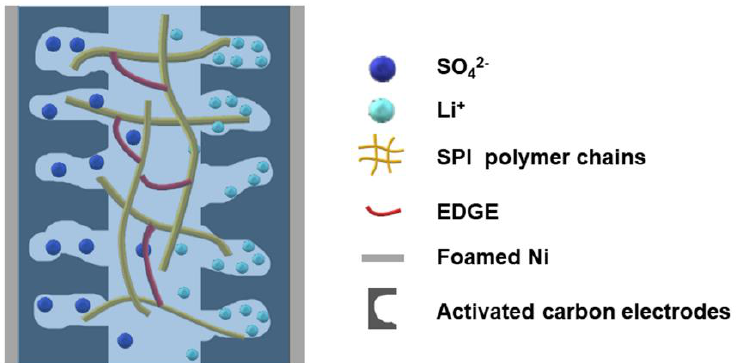
Figure 10. A simplified illustration of ion migration at the interface between the GPE and activated carbon electrodes.